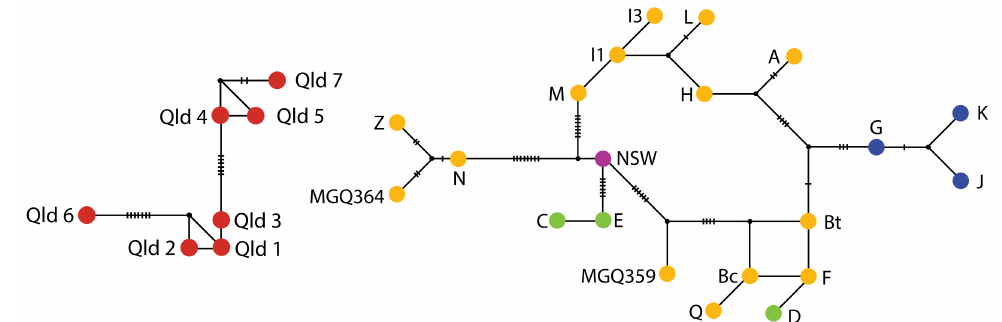
Figure 4. Haplotype networks based on analysis of haplotypes from the mitochondrial control region of P. x. xanthopus and P. x. celeris (red). The red Qld samples were too distantly related to the P. x. xanthopus haplotypes to form a single network. Haplotypes from P. x. xanthopus are outlined in Supplementary Table S1 and the unresolved phylogenetic tree in Supplementary Figure S3. Yellow samples correspond to populations from the Flinders Ranges, blue from the Gawler Ranges, green from Olary Hills, and purple from NSW (refer to Figure 1 for